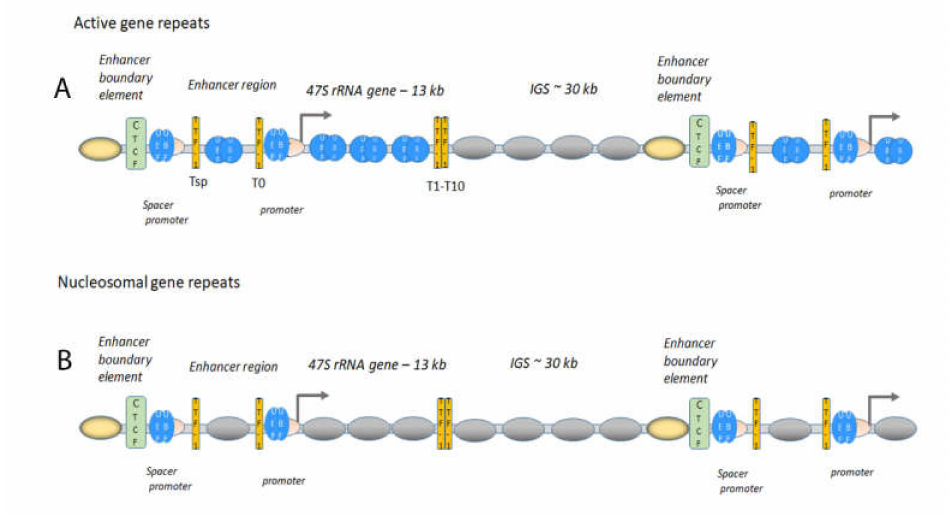
Figure 2. Chromatin architecture at the rDNA at the active ( A ) and the poised state ( B ). ( A ) The genes are organised head-to-tail; UBF (bleu ovals) and SL1 (pink crescent) are bound to the promoter and the spacer promoter (depicted in the figure). TTF-1 (yellow bars) is bound to its binding sites, depicted Tsp downstream of the spacer promoter, T0 at the promoter, and T1-T10, at the end of the 47S rRNA gene. UBF is associated with the active 47S rRNA gene body and with the upstream enhancer region and the IGS downstream of the termination of the gene (T1-T10) is nucleosomal (grey ovals). CTCF (green rectangle) is flanking the spacer promoter with positioned nucleosomes with active histone marks and H2AZ (yellow oval nucleosome). These actively marked nucleosome are also present in the poised state in the bottom panel). ( B ) The poised state have nucleosomes (grey ovals) in the gene repeat, UBF (bleu ovals and SL1 (pink crescent) at the promoter and spacer promoter. TTF-1 (yellow bars) is binding to its sites, Tsp, T0, T1-T10 in the gene repeat. CTCF (green rectangle) is also here flanking the spacer promoter with positioned nucleosomes with active histone marks and H2AZ (yellow oval